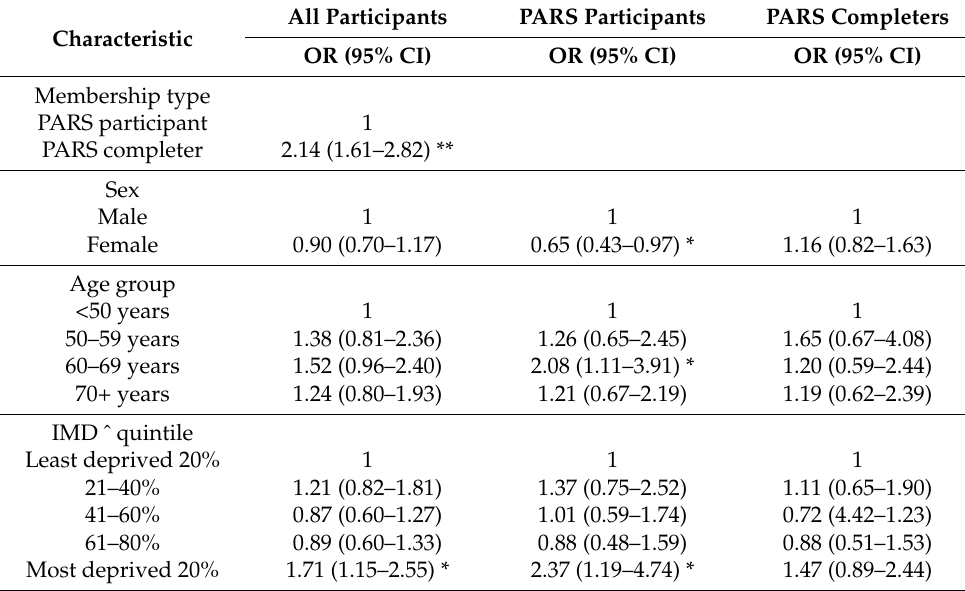
Table 7. Odds ratios of achieving higher categorical levels of weekly leisure centre-based physical activity by demographic